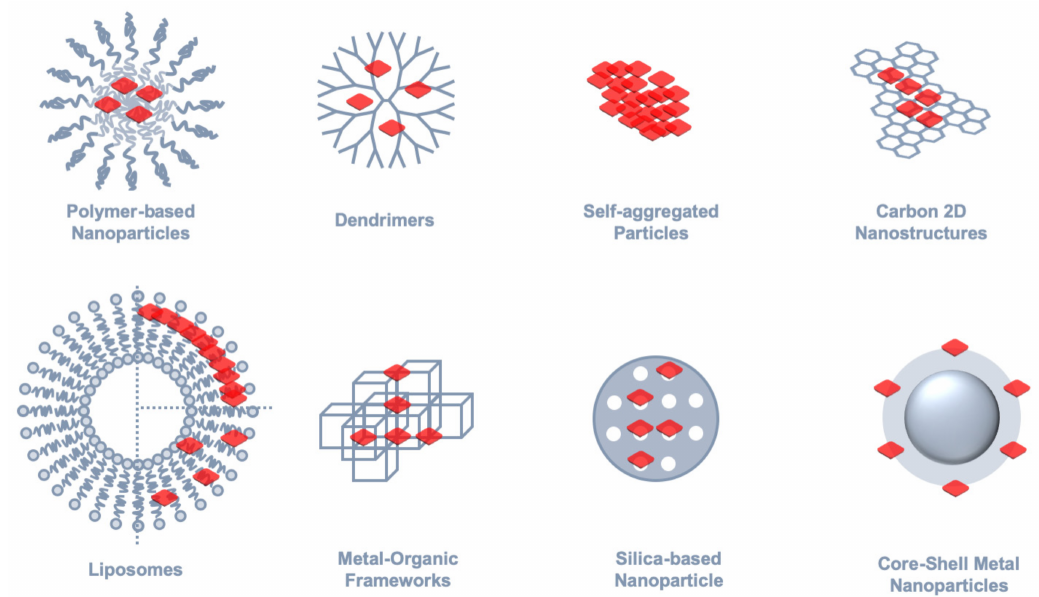
Figure 6. Examples of supramolecular assemblies and nanostructures involving porphyrins, phthalocyanines, and their analogues that have found application in imaging